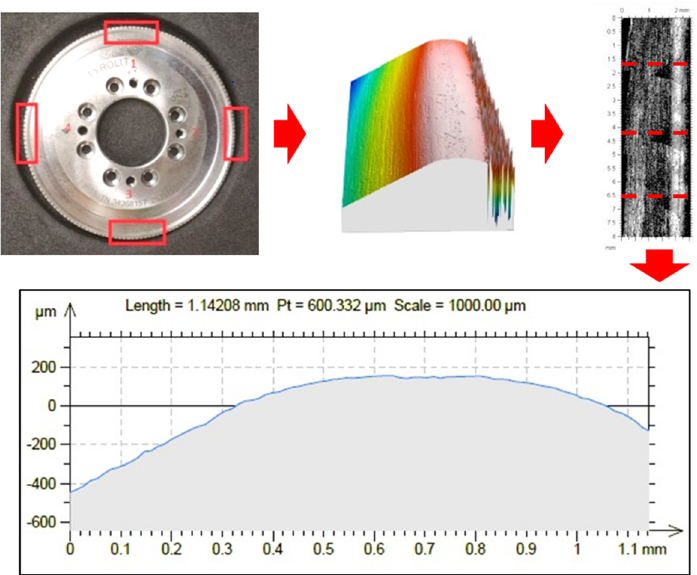
Figure 5. Rotary dresser measurement to characterize the wear.